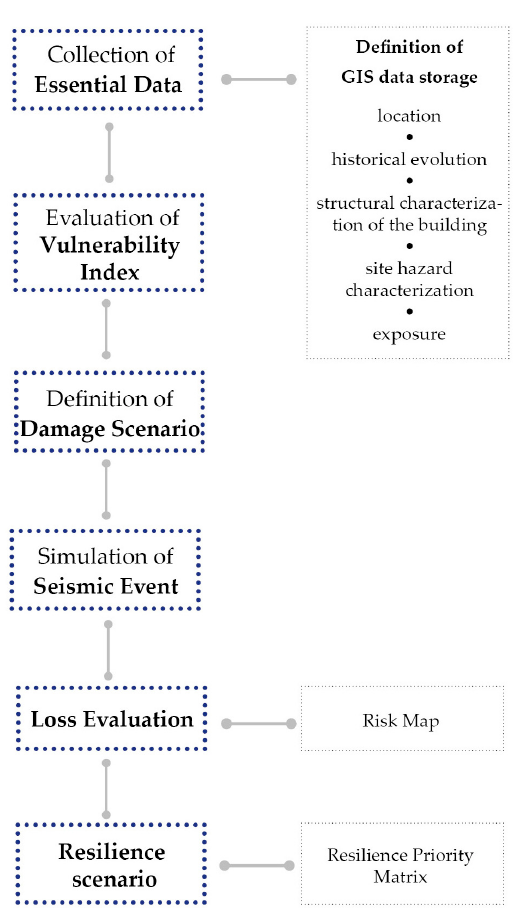
Figure 1. Proposed